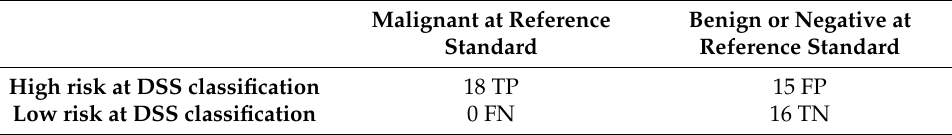
Table 8. Reference standard and DSS classification results of the tested patients. Number of true positive (TP) and false positive